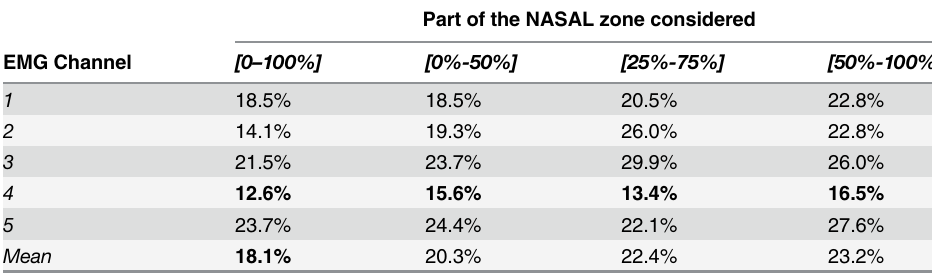
Table 7. Mean error rates using a classification technique based on the majority of nasal/non-nasal frames for each nasal zone. Part of the NASAL zone